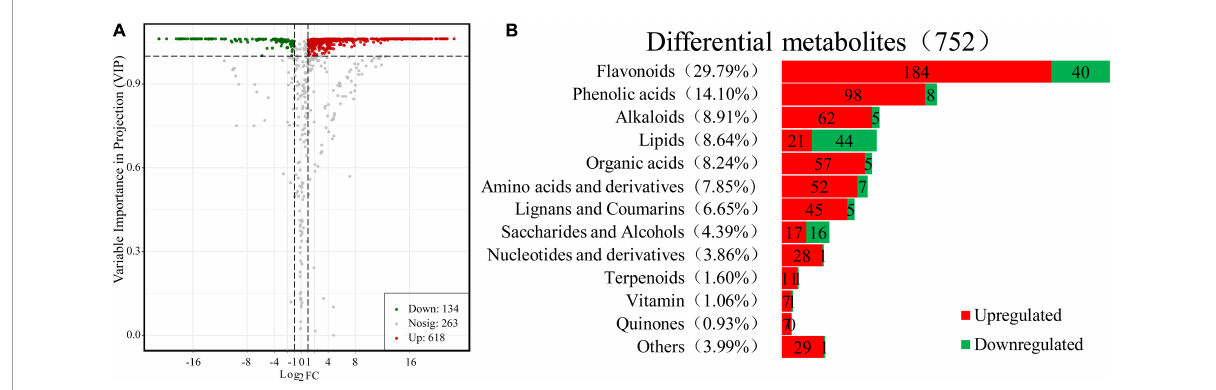
FIGURE3 Differential metabolites between FJ and FMT. (A) Volcano plot of the 752 differential metabolites identified. Differential metabolites were defined as metabolites with VIP ≥ 1 and absolute log 2 FC (fold change) ≥ 1 in FMT relative to FJ. (B) Column chart depicting the biochemical categories of differential metabolites identified between FJ and